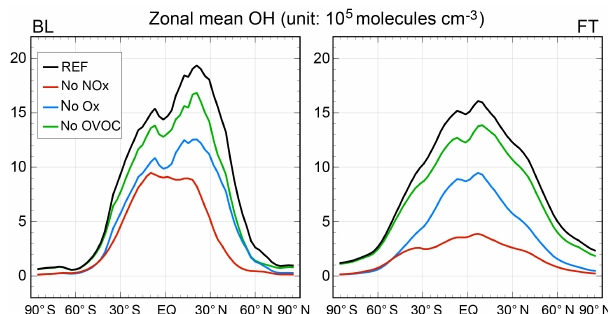
Figure 11. Zonal annual mean OH concentrations calculated in the reference simulation (black) and by successively excluding OH re- cycling through the NO x , O x and OVOC